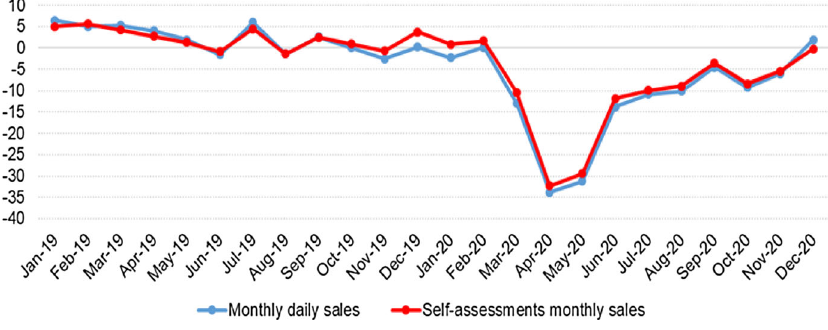
Fig. 2 Daily sales versus self-assessments monthly sales, Y–o-Y